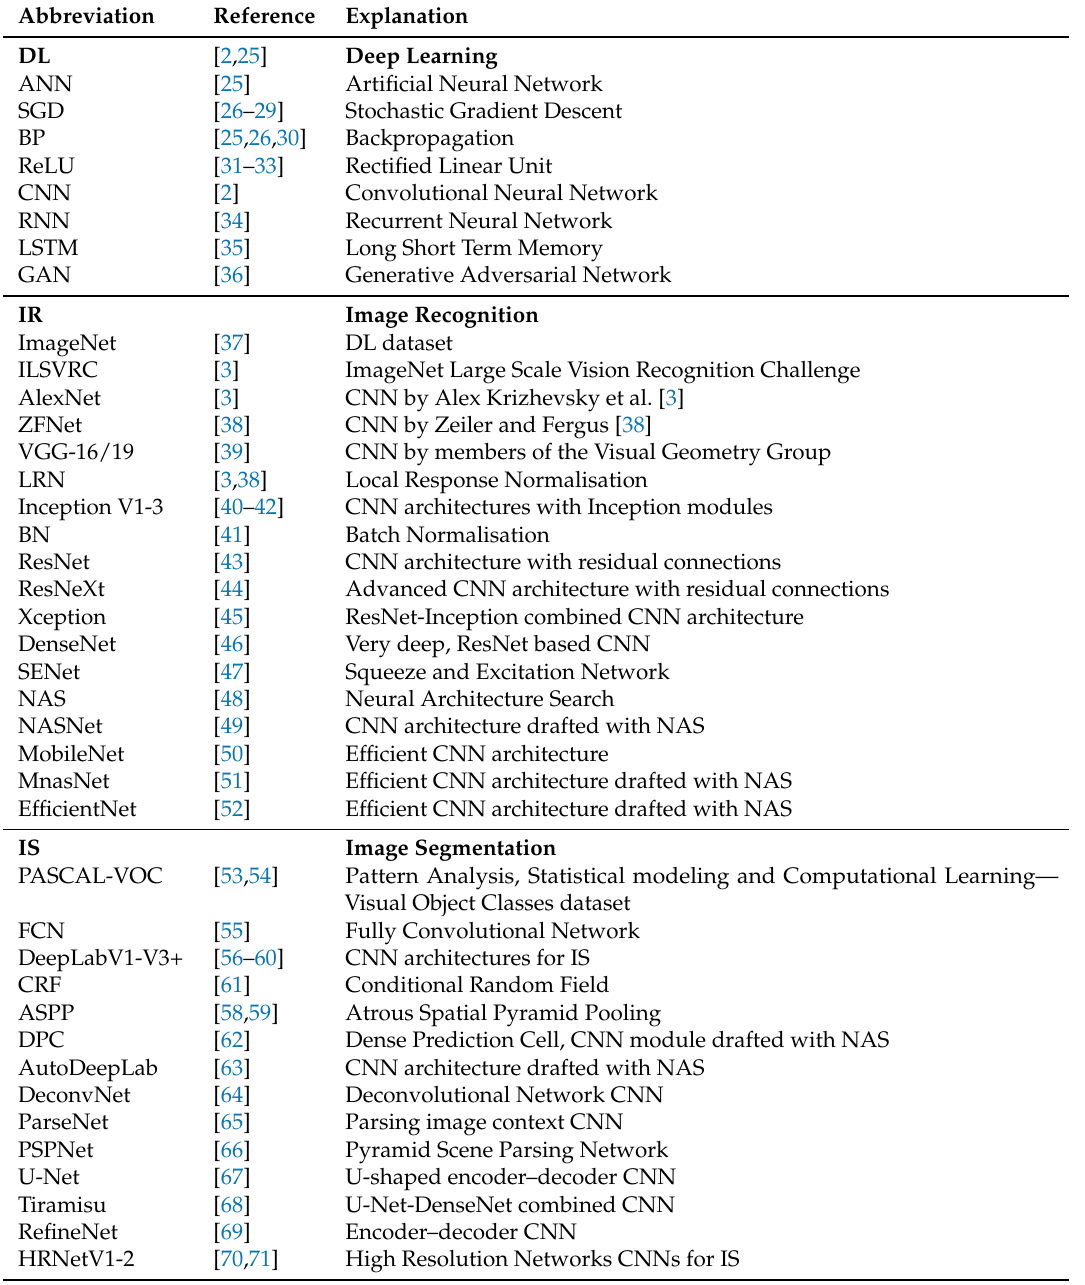
Table 1. List of abbreviation, explanations and the original literature or further discussion. The sorting of the table reflects the structure of Sections 2 and 3. At the same time, it is a guiding thread through the milestone-publications on deep learning architectures of convolutional neural networks for image recognition, segmentation and object detection from 2012 to late